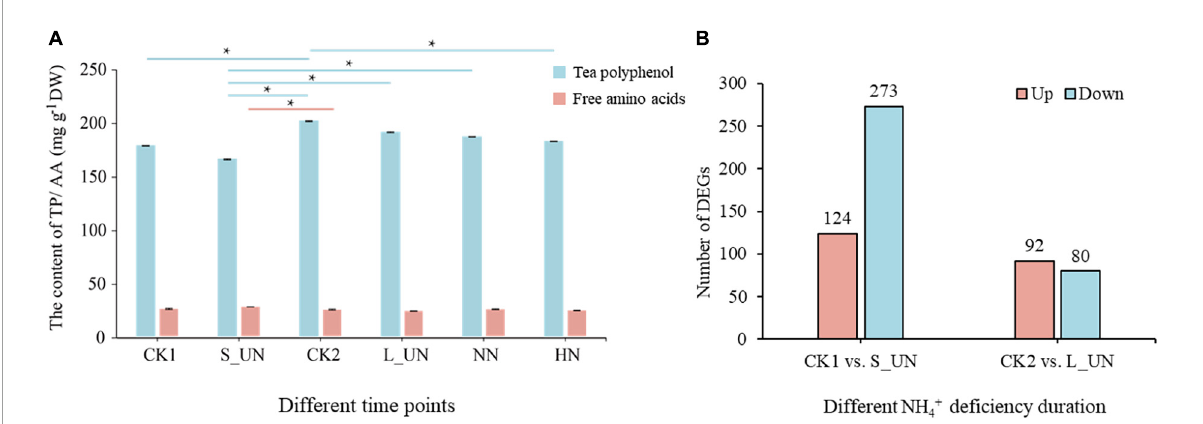
FIGURE2 An overview of different periods of NH 4 + treatments. (A) The content of tea polyphenols and free amino acids in tea plants at different time points. (B) Differentially expressed genes between different NH 4 + deficiency durations (S_UN vs. CK1 and L_UN vs.CK2). * indicates a significant difference ( p < 0.05).